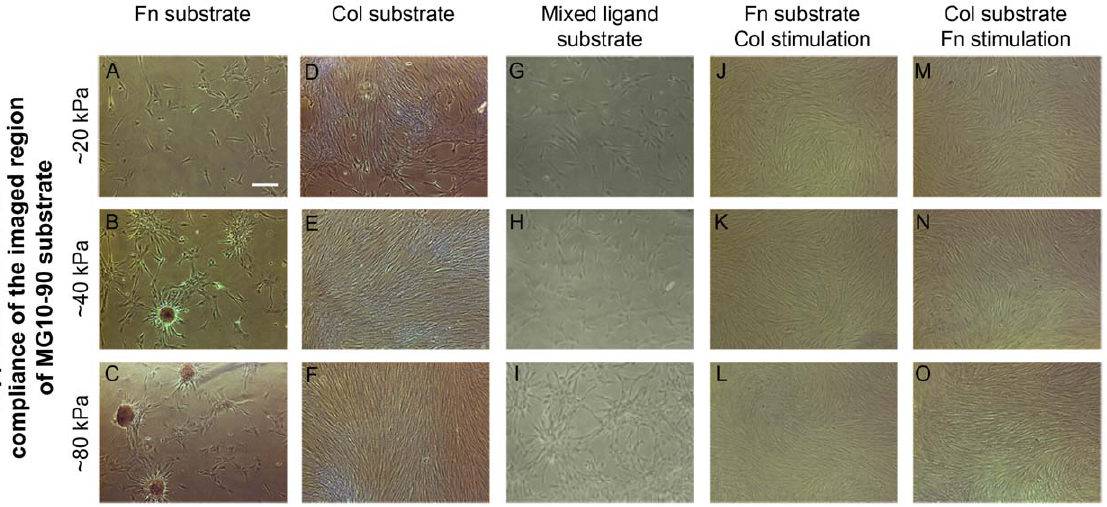
Figure 2. Differentiation from different culture conditions. Bone marrow stromal cells were cultured on MG10–90 substrates as described in the text for 14 days and processed for osteogenic behavior. (A–C) On fibronectin substrates osteogenic behavior was indicated by nodule formation on intermediate ( , 40 kPa) and stiffer ( , 80 kPa) subregions. (D–F) On collagen substrates osteogenic behavior was not seen. (G–I) When collagen was presented in the media, osteogenic behavior was not seen on fibronectin substrates. (J–L) Fibronectin media presentation did not appear to alter appearance of cells. (M–O) On mixed ligand substrates where the bulk ligand density was distributed using 20 m g/ml of total protein, osteogenic differentiation was not observed. Scale bar represents 100 m m.